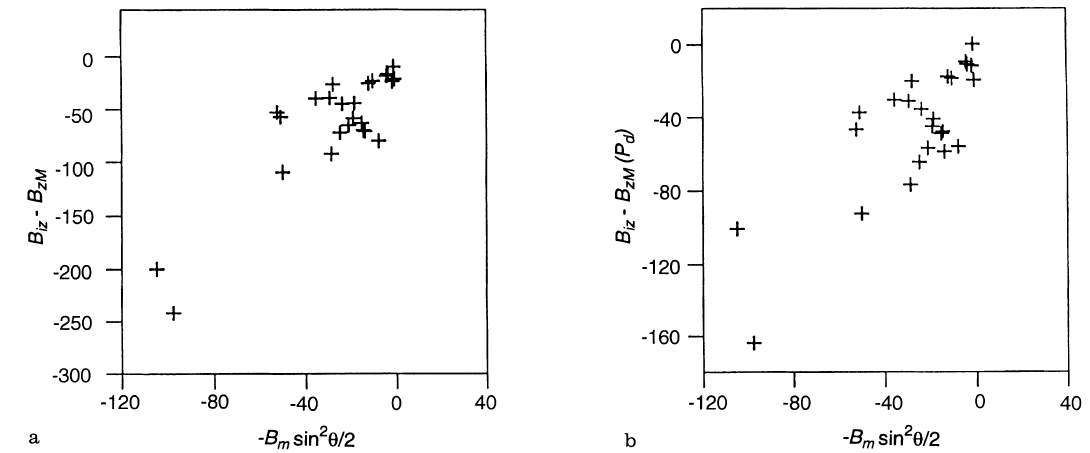
Fig. 7a,b. Scatter plots of (cid:100) B z versus B m ? z values. a (cid:100) B z (cid:136) B iz (cid:255) B zm . b (cid:100) B z (cid:136) B iz (cid:255) B zm (cid:133) P d